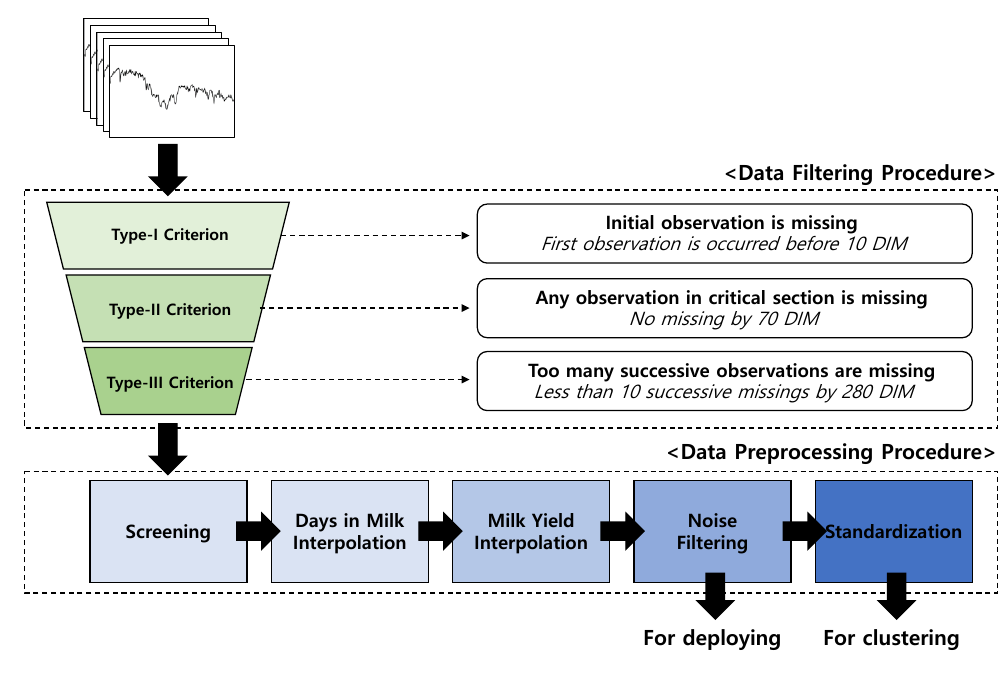
Figure 1. Data filtering and preprocessing procedure.